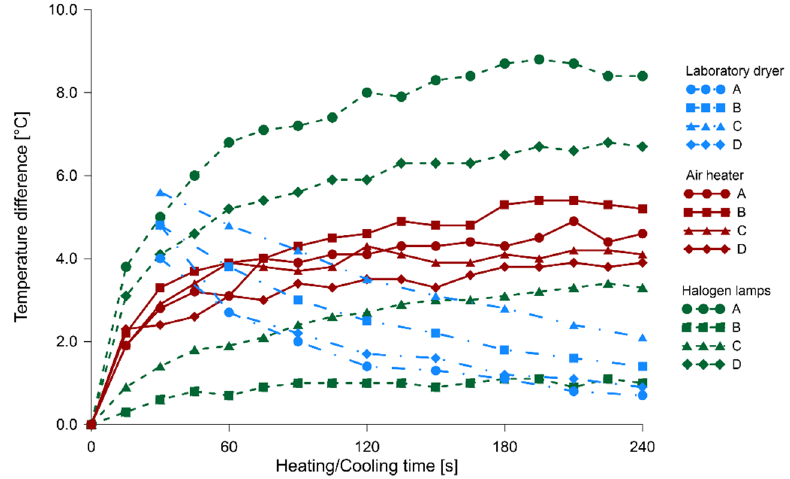
Figure 7. The relationship between heating/cooling time and temperature difference of solid fir wood and knots.